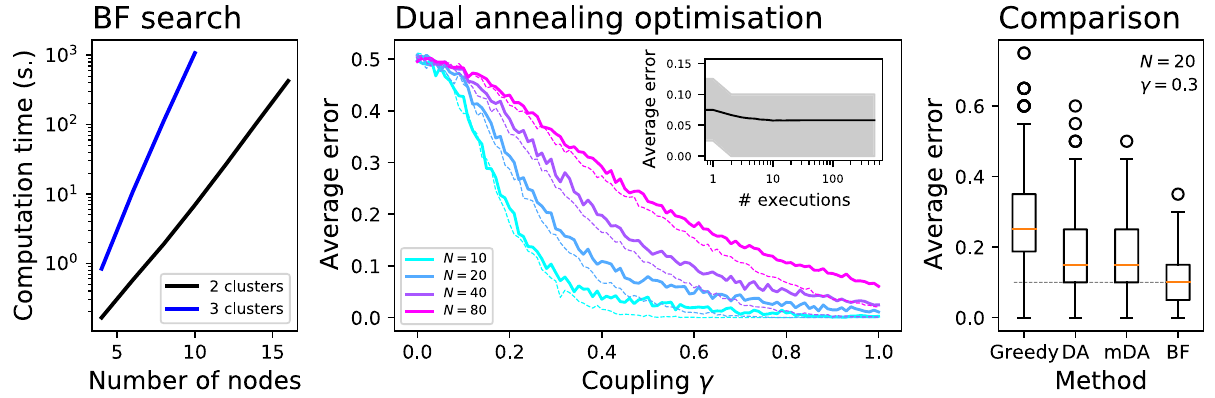
Figure 9. Computation cost and optimisations. (Left) Evolution of the computation cost of the brute force algorithm as a function of the number of nodes to be clustered, for C = 2 (black line) and C = 3 (blue line). The cost is measured in seconds, calculated on an Apple iMac with an hex-core Intel Core i5 at 3.3 GHz and executed on a single core. (Center) Average error obtained by a dual annealing optimisation, for C = 2 , time series composed of 500 values, and as a function of the coupling constant γ and the number of nodes N . Solid lines represent results for one single execution of the optimisation algorithm, while dashed lines the best solution, measured as the one with the smallest J , among 50 executions with random initial conditions. The inset represents the evolution of the error as a function of the number of executions of the dual annealing optimisation, for N = 40 and γ = 0.6 ; the grey band depicts the evolution of the 10-90 percentile interval over 10 3 realisations. (Right) Distribution of the errors, for N = 20 , C = 2 and γ = 0.3 , obtained by four algorithms: from left to right, greedy optimisation, dual annealing (DA) optimisation, dual annealing optimisations with 50 executions (mDA), and brute force (BF). Horizontal orange lines depict the median of each distribution and circles their